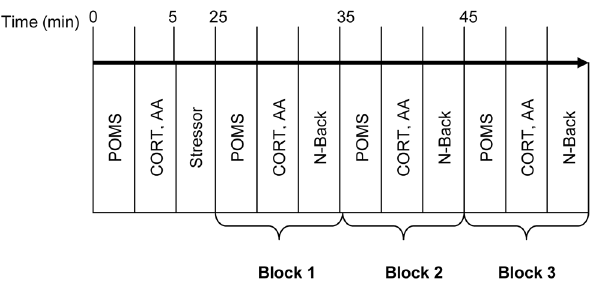
Fig. 2. Schematic representation of the study schedule. During the study sessions, participants first completed baseline measures of the POMS and provided saliva samples for analysis of cortisol (CORT) and alpha-amylase (AA). They completed one of three experimental stressors, or the non-stressful control task. They then completed three blocks in succession, each consisting of the POMS, salivary measures, and a spatial N-Back